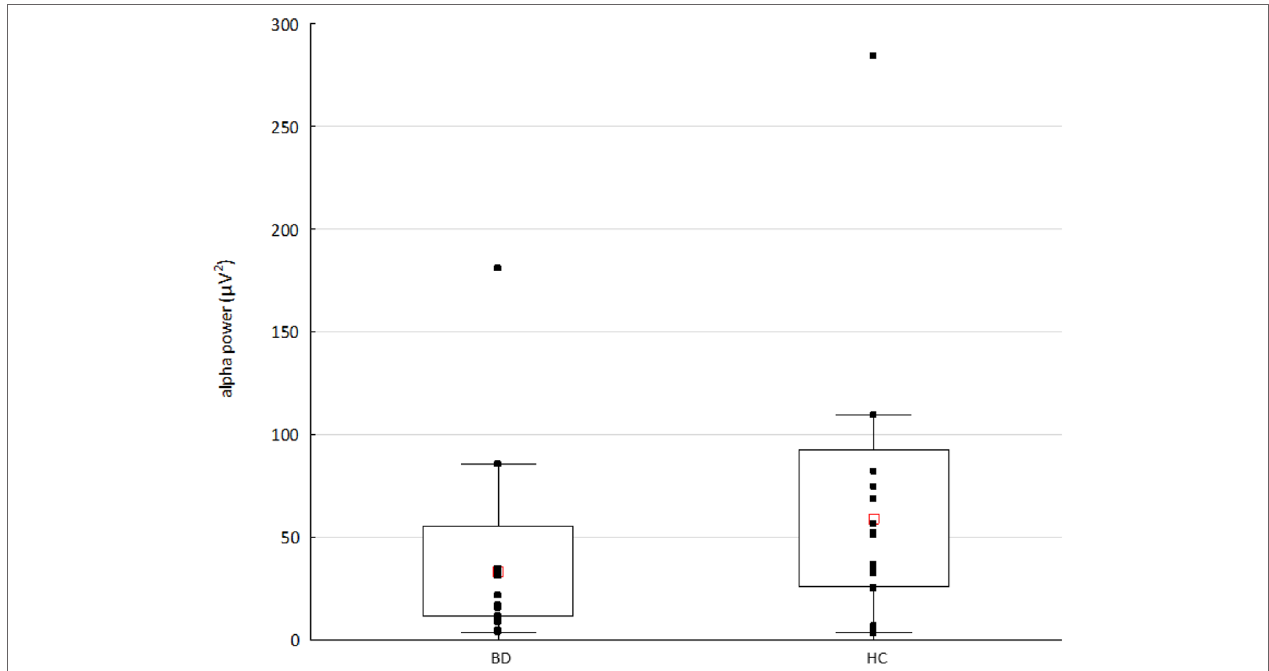
FIgURE 3 | The alpha power in patients with bipolar disorder (BD) and healthy controls (HC). Raw data are plotted on top of each boxplot showing the mean ( ), 95% confidence interval (box plot area), and non-outlier range (whiskers). The x-axis represents the subject group; the y-axis represents the average alpha (8–14 Hz) power across 204 channels. Note significantly decreased alpha power in the BD compared to HC group (p < 0.03, Z value